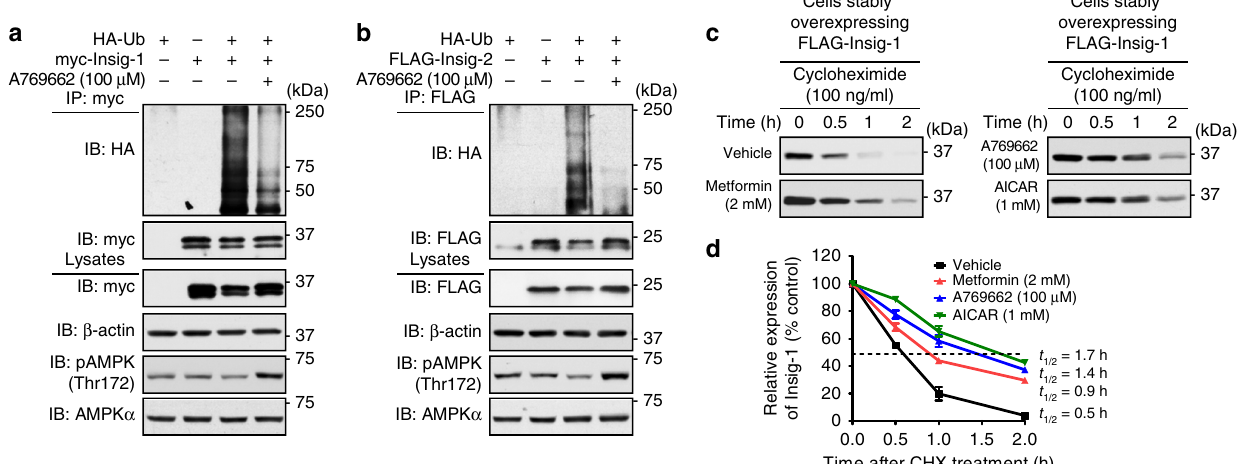
Fig. 3 Administration of AMPK agonist represses the ubiquitination and degradation of Insig. a , b AMPK agonist decreases the ubiquitination levels of Insig-1 and Insig-2. Plasmids encoding myc-tagged Insig-1 ( a ) or FLAG-tagged Insig-2 ( b ) were co-transfected with HA-tagged ubiquitin (HA-Ub) for 24 h, followed by treatment with 100 μ M A769662 for 4 h. The cell lysates were incubated with myc or FLAG antibodies and puri fi ed with protein A/G- Sepharose beads. The precipitates and lysates were individually immunoblotted with indicated antibodies. c , d AMPK agonists reduce the degradation rate of Insig-1. HEK293 cells stably expressing FLAG-tagged Insig-1 were treated with 100 μ M A769662, 2 mM metformin, and 1 mM AICAR, followed by incubation in the medium containing 100 ng/ml cycloheximide for the indicated time. Data are presented as the mean ± SEM, n =